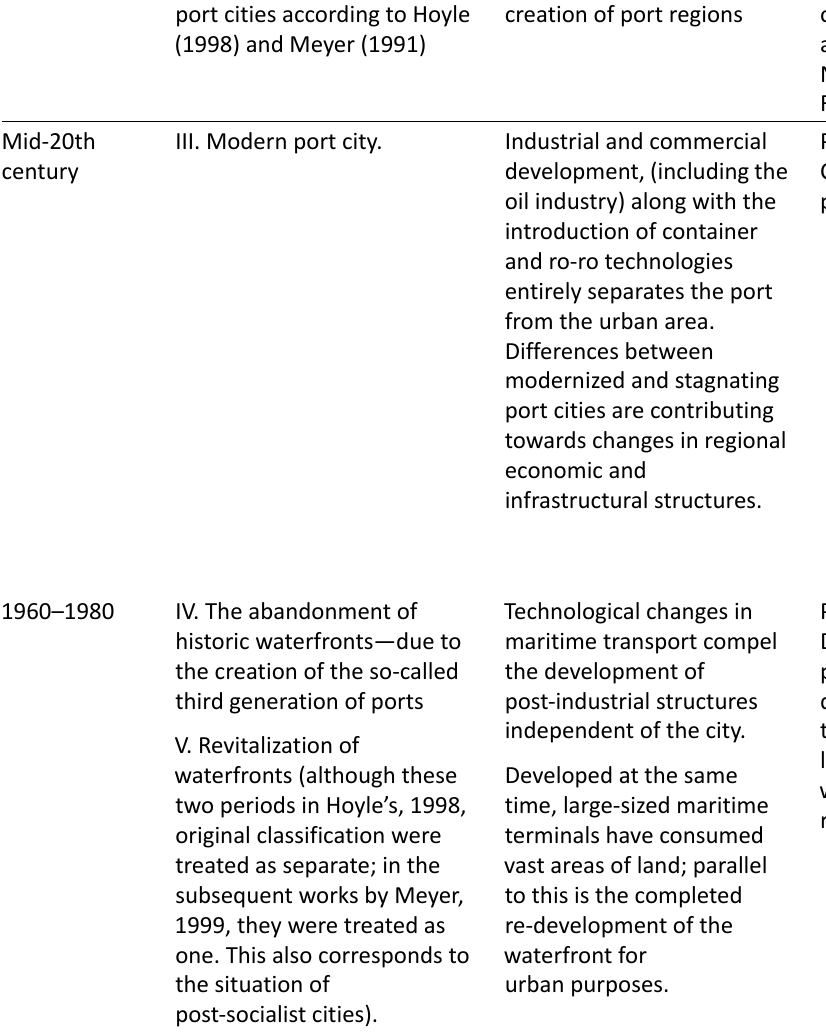
Table 1. (Cont.) Comparison of evolutionary stages of the port‐city interrelation.